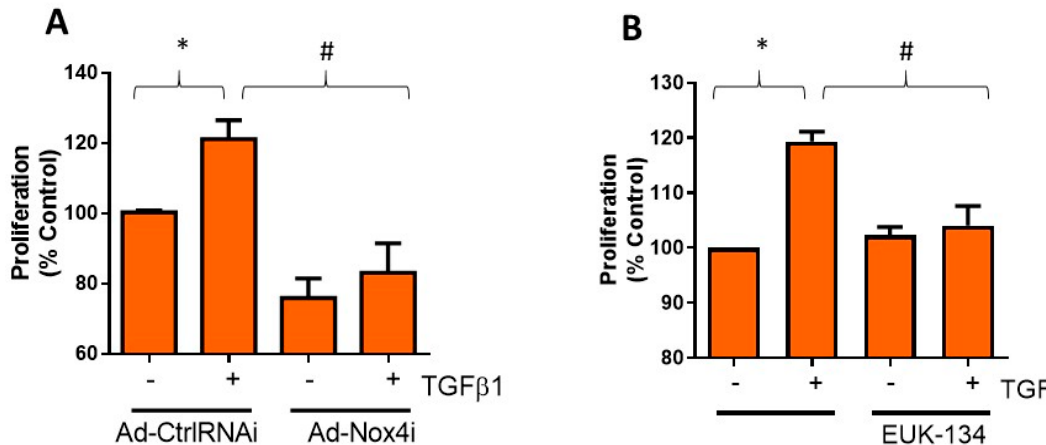
Figure 4. Effect of Nox4 inhibition and EUK-134 on proliferation of human Tenon’s fibroblasts (HTFs). ( A ) Treatment of HTFs with Ad-Nox4i inhibited the stimulatory effects of TGF β 1 (5 ng/mL) on cell proliferation. ( B ) Similarly, H 2 O 2 scavenger EUK-134 (25 µ M) inhibited TGF β 1-induced cell proliferation. All data are mean ± SEM from three independent experiments, * p < 0.05 from control without TGF β 1 treatment; # p < 0.05 from treated cells with TGF β 1.